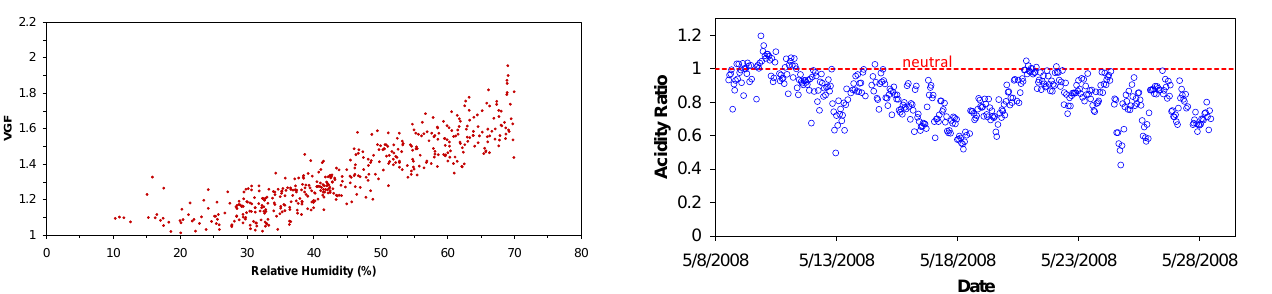
Fig. 5. Acidity ratio versus time as calculated from the molar ratio of ammonium over nitrate and sulfate as measured by the Q-AMS with one hour